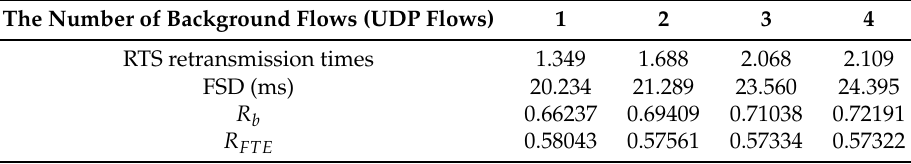
Table 2. The value of RTS retransmission times, Frame Service Delay (FSD), R b and R FTE . The Number of Background Flows (UDP